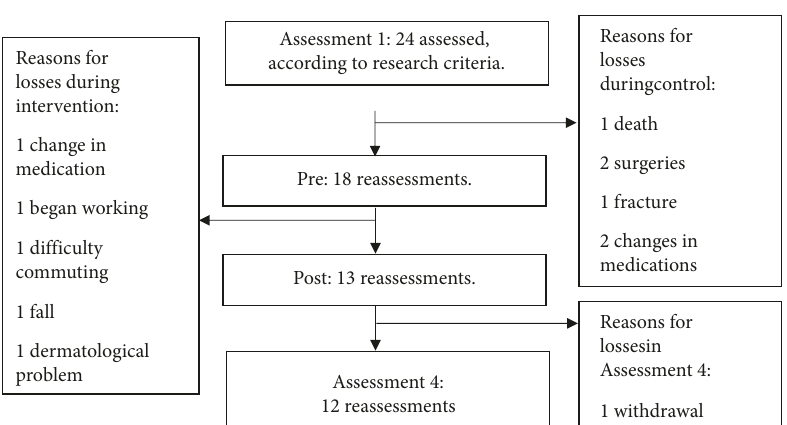
Figure 3: Phase of relaxation.